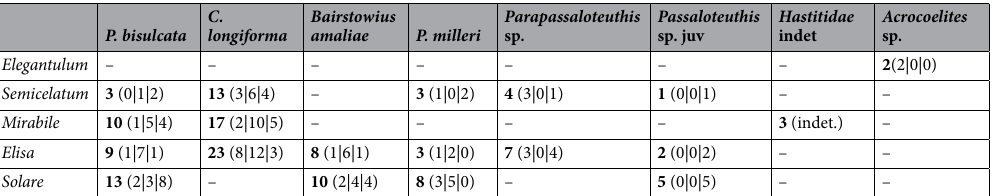
Table 1. Table of occurrences of species in the five ammonite subzones in the format: absolute abundance